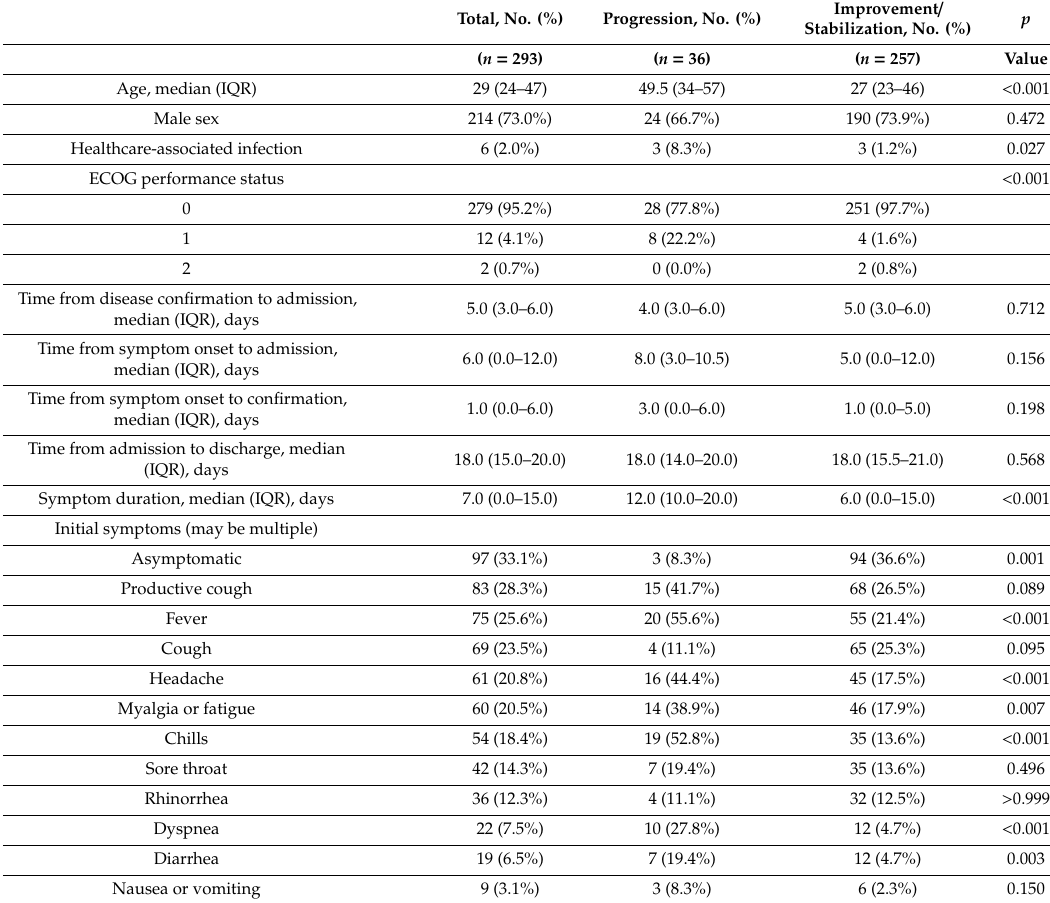
Table 1. Baseline characteristics of patients with COVID-19, before propensity-score matching *. Total, No.